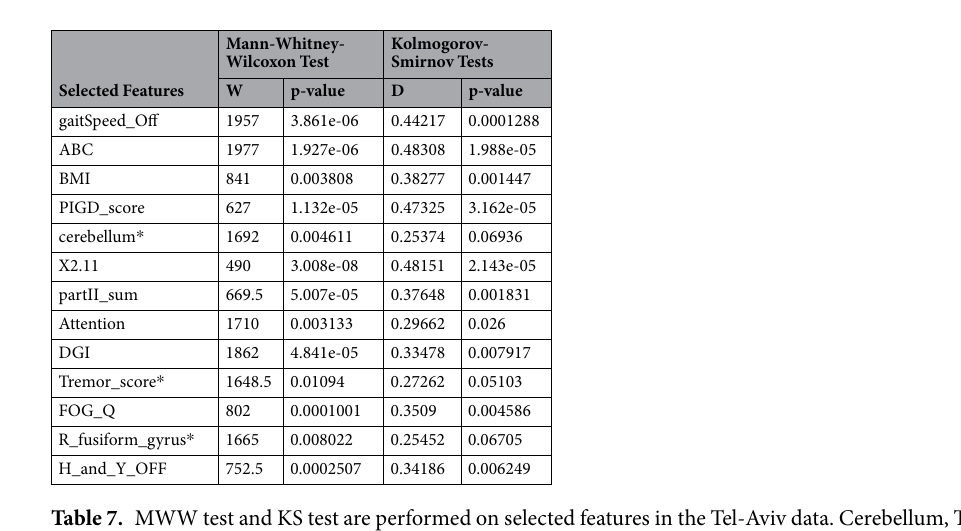
Table 7. MWW test and KS test are performed on selected features in the Tel-Aviv data. Cerebellum, Tremor_ score and R_fusiform_gyrus are excluded because their p-values > 0.05, for the KS